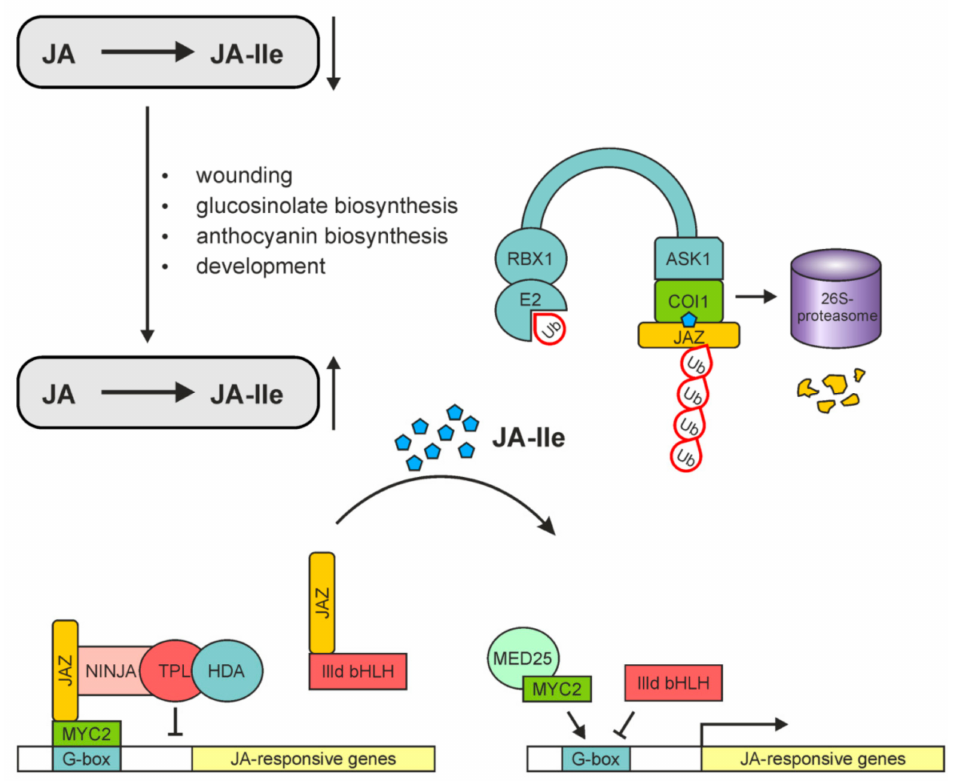
Figure 5. A simplified model of JA-Ile perception and signaling via the SCF COI1 -JAZ co-receptor complex. At low level of JA-Ile, the JAZ repressors recruit the co-repressor complex consisting of NINJA, TOPLESS (TPL) and the histone deacetylase (HDA), interact with and repress positive regulators of JA signaling such as the transcription activator MYC2, and also inhibits negative regulators of JA signaling such as the transcriptional repressors IIId bHLH factors. Upon external stimuli or developmental changes levels of JA-Ile are elevated leading to perception of JA-Ile by the COI1-JAZ co-receptor and degradation of JAZs via the 26S proteasome. The downstream transcription factors are activated to regulate synergistically or antagonistically expression of JA-responsive genes and JA responses. MYC2 associates with the MED25 subunit of the mediator complex, binds to the G-box motif of the target promoters and activates JA-responsive genes. The IIId bHLH factors antagonize MYC2 via competitive binding to the G-box motif and inhibiting JA-responsive genes. COI1, ASK2, CULLIN1, Rbx and E2 are components of the SCF COI1 complex. Ub, ubiquitin. Modified with permission from Reference [3] (color in